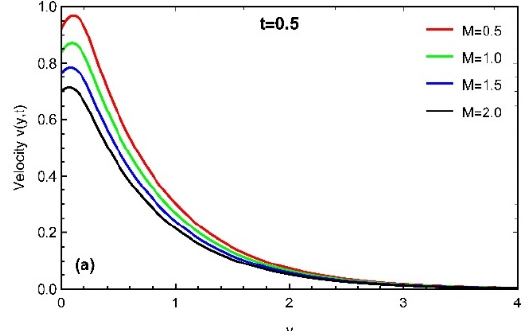
Figure 11. Variation in momentum field due to Re parameter with α = β = γ = 0.7, Pr ef f = 1.4, Sc ef f = 1.1, M = 1.75, Gr = 0.75, Gm = 0.5, θ 1 = θ 2 = π ( a ) t = 0.5 ( b ) t = 0.7 ( c ) t = 0.9.